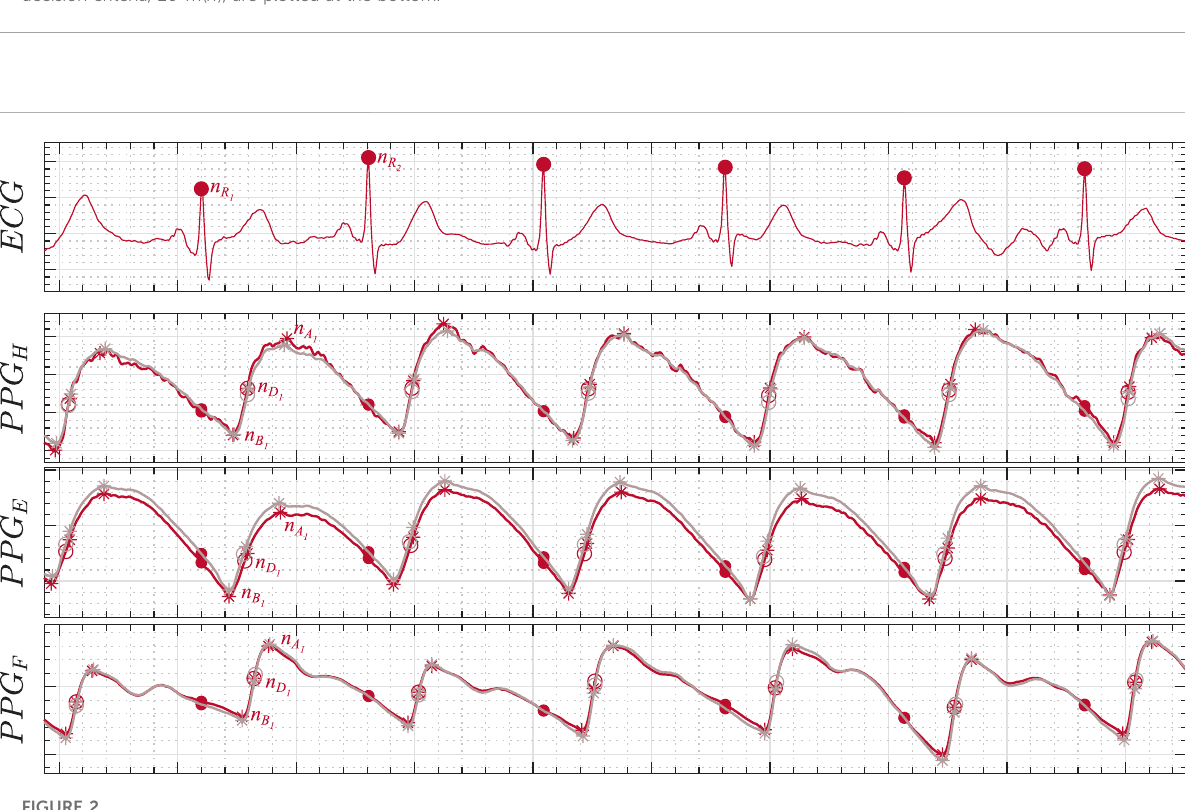
FIGURE 2 ECG and PPG synchronous recording illustration. The three PPG signals are at the forehead ( PPG H ), at the earlobe ( PPG E ), and at the fi nger ( PPG F ),respectively.TheFPdelineatedare n R fortheECGR-waveinstant, n D forthePPGmaximumup-slopeinstant, n A forthePPGapexpoint,and n B for the PPG basal point. Both red PPG (R-PPG, in red) and infrared PPG (IR-PPG, in gray) lights are also illustrated. Refer Allen (2007) and Charlton et al. (2018) for more information on the morphology of PPG in different body